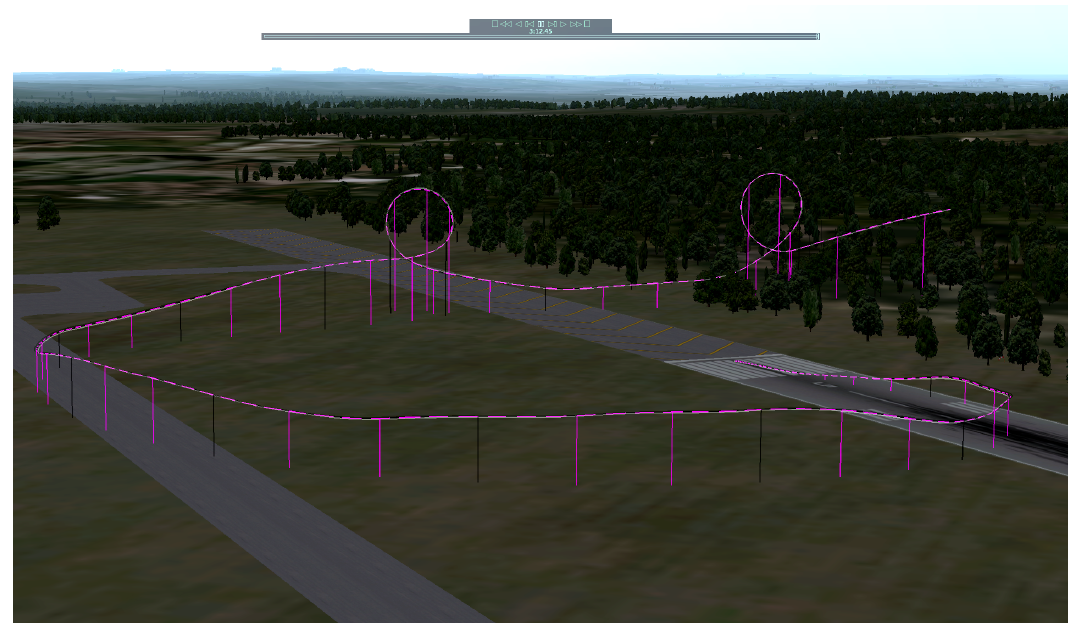
Figure 5. Aerobatics scenario with two loopings .